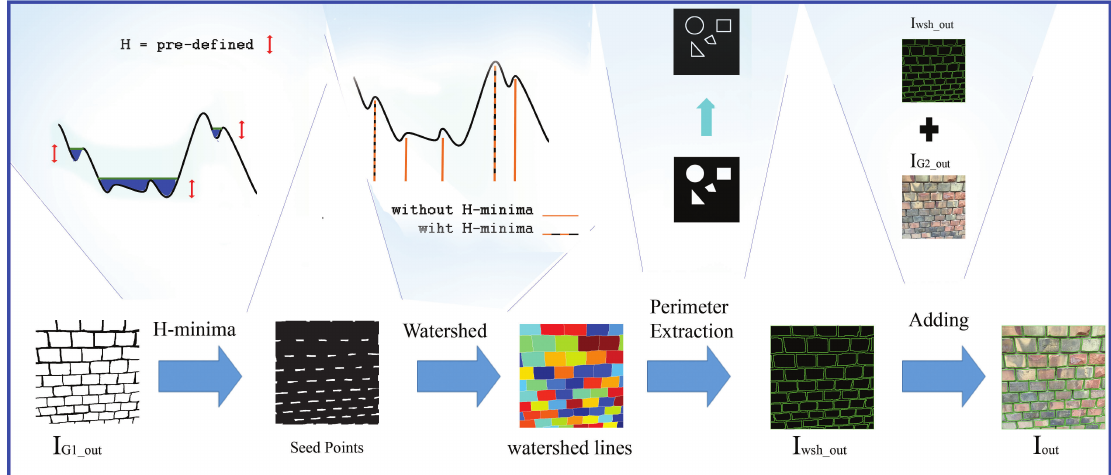
Figure 6. Dataflow of the Segmentation Stage, which extracts the accurate brick contours on the inpainted wall